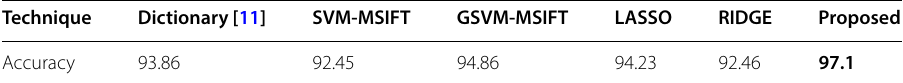
Table 4 Accuracy for different classifiers worked on FERET database Technique